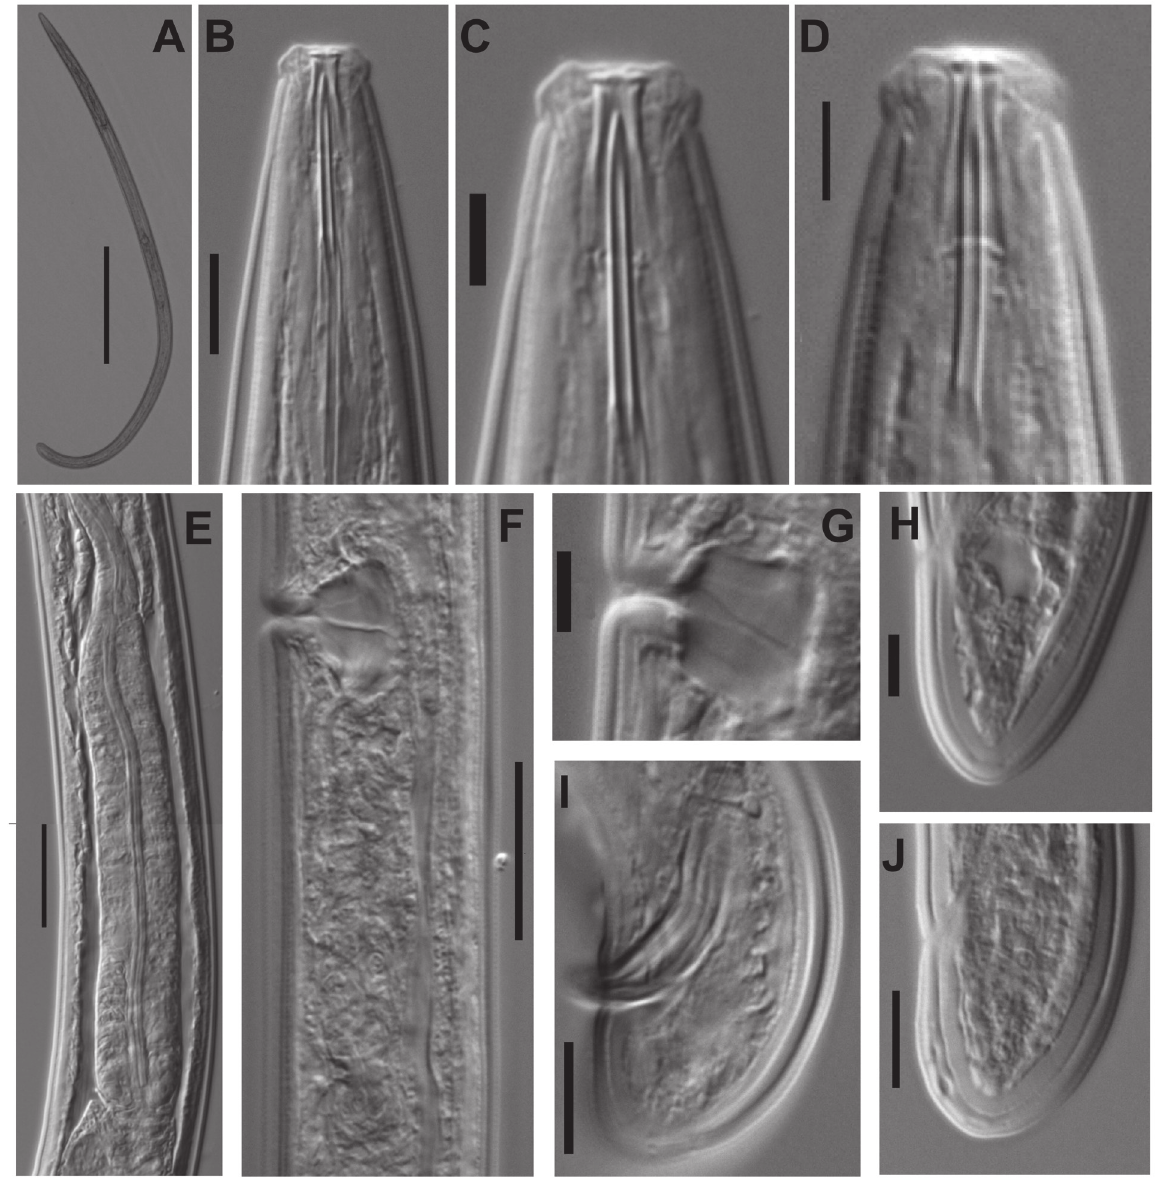
Fig. 3. Pungentus engadinensis (Altherr, 1950) (LM). A . ♀, entire. B-D . Anterior region in median view. E . Pharyngeal expansion. F . ♀, part of posterior genital branch. G . Vagina. H, J . ♀, caudal region. I . ♂, caudal region and spicules. (Scale bars: A = 200 µm; B, J, K = 10 µm; C, D, G, I = 5 µm; E, F = 20